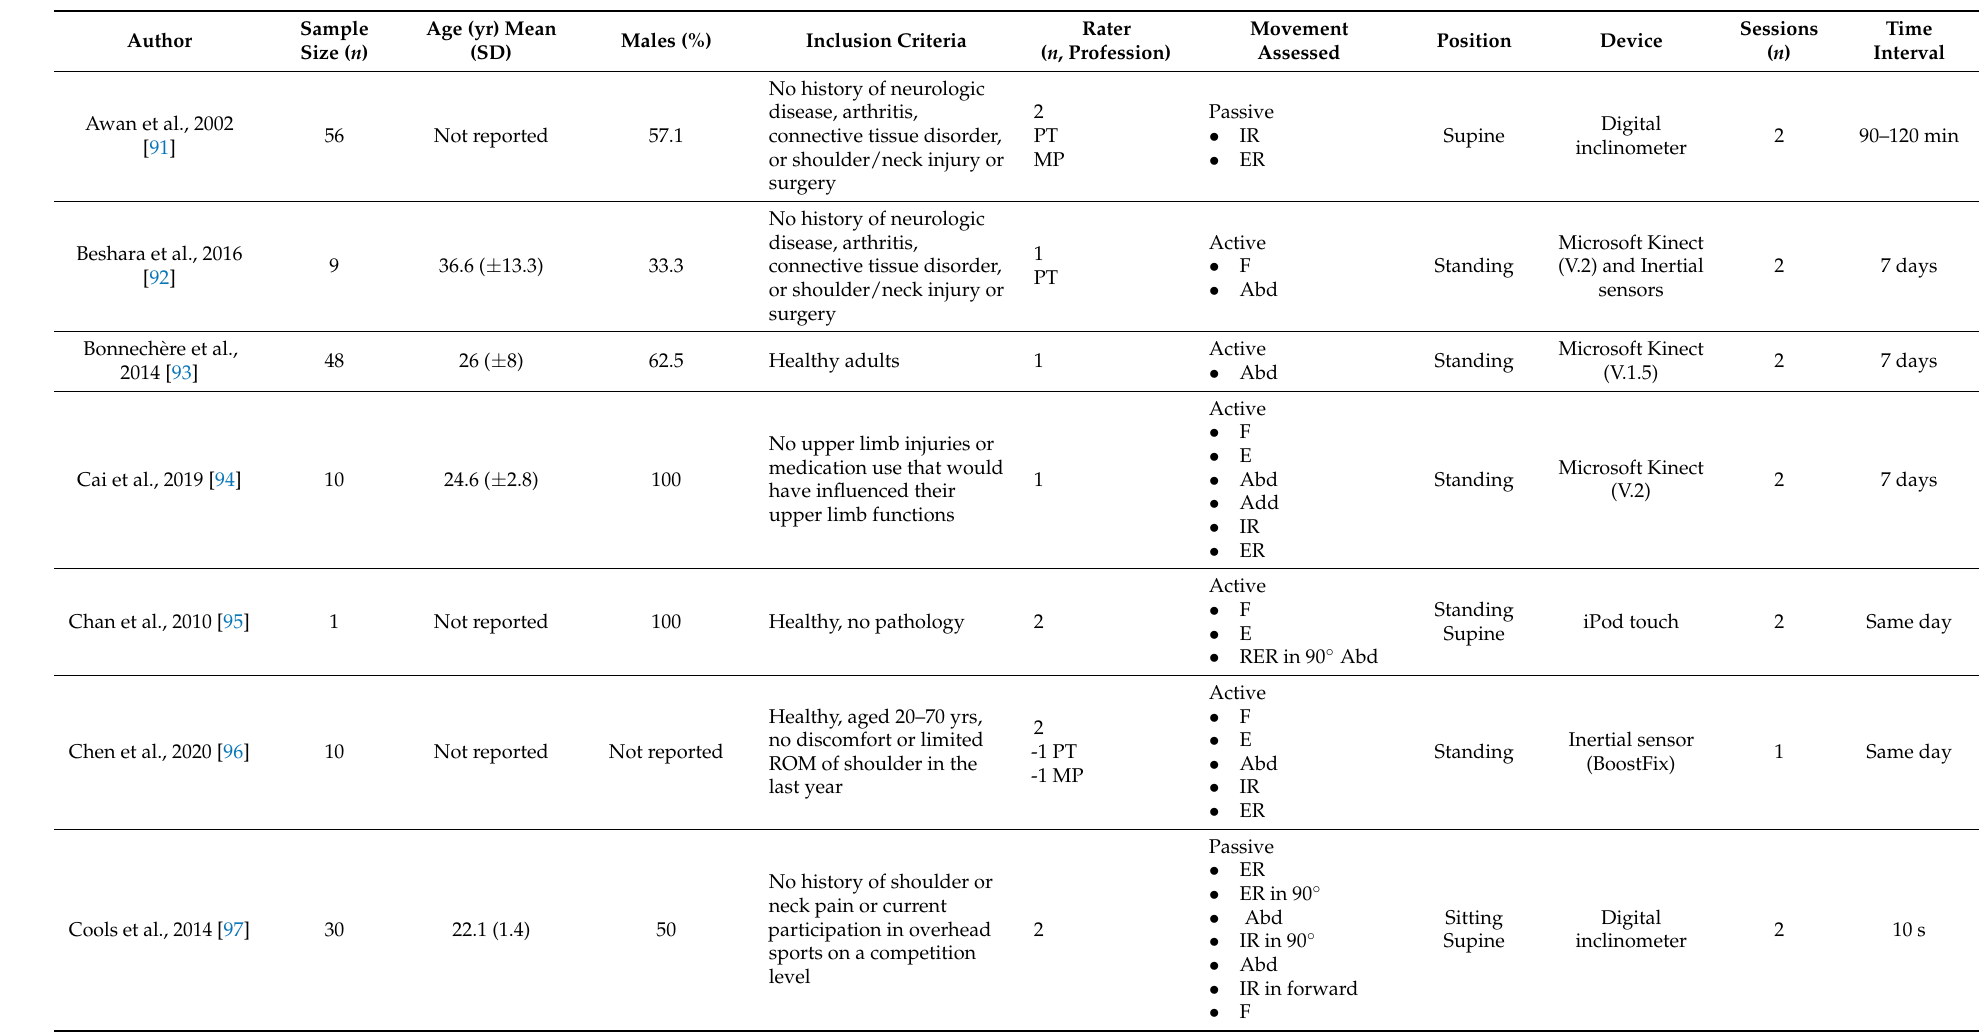
Table 1. Characteristics of studies included in this